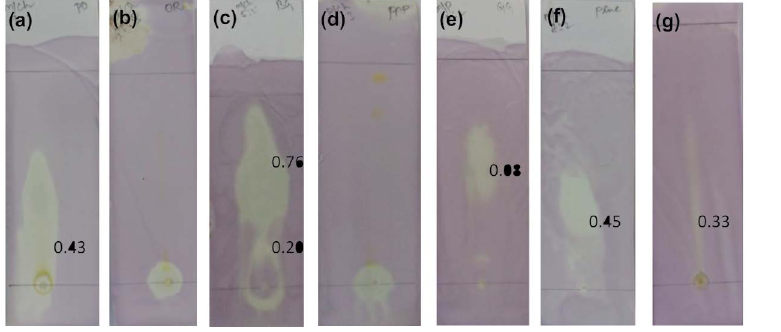
Fig. 1. TLC bioautography for antioxidant activity ( a) Punica granatum, (b) Citrus reticulata, (c) Vitis amurensis, (d) Carica papaya, (e) Vitis vinifera, (f) Ananas comosus, (g) Ficus carica DPPH